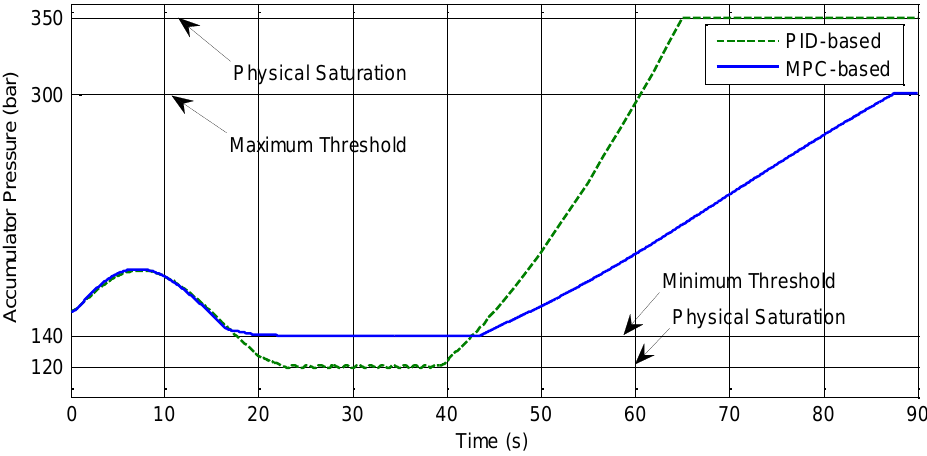
Figure 14. Systems behaviors with physical saturations and state